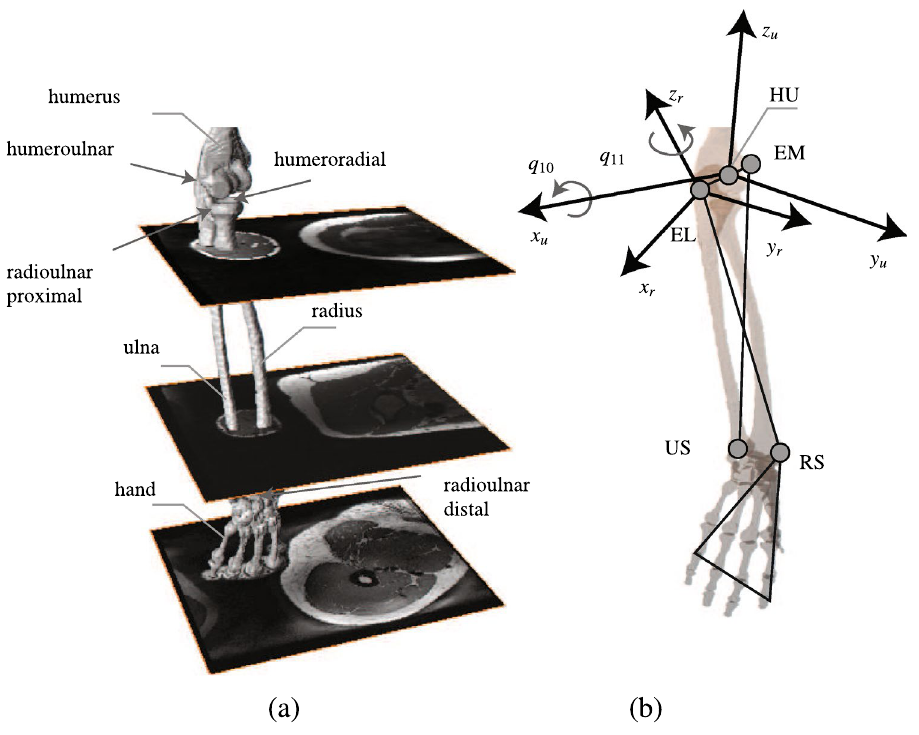
Figure 1. Modeling the elbow kinematics. ( a ) MRI scans of the forearm from the same subject are used to define the surface boundaries of the ulna and the radius. The hand is assumed to be rigidly tied to the radius. The elbow consists of 4 anatomical joints including humeroulnar, radioulnar proximal/distal, and humeroradial joints. ( b ) Two non-perpendicular hinge joints are considered to replicate the elbow motion. To construct the bone-fixed frames, 3 landmarks namely EM, HU, and EL are borrowed from the humerus. Two landmarks namely US and RS are also used from ulna and radius, respectively. { HU , ˆ x u , ˆ y u , ˆ z u } and { EL , ˆ x r , ˆ y r , ˆ z r } are the ulna and the radius frames, respectively. The joint coordinates are considered to be coincide with the bone- fixed frames. Two generalized coordinate q 10 and q 11 are used to uniquely define elbow flexion/extension and pronation/supination,